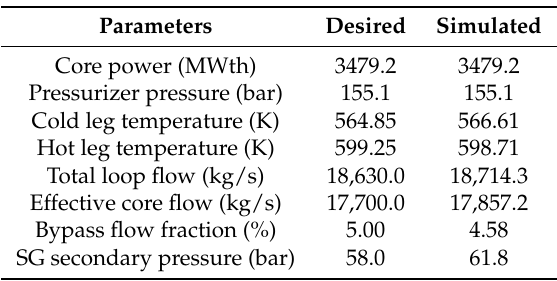
Table 3. Steady-state initialization.